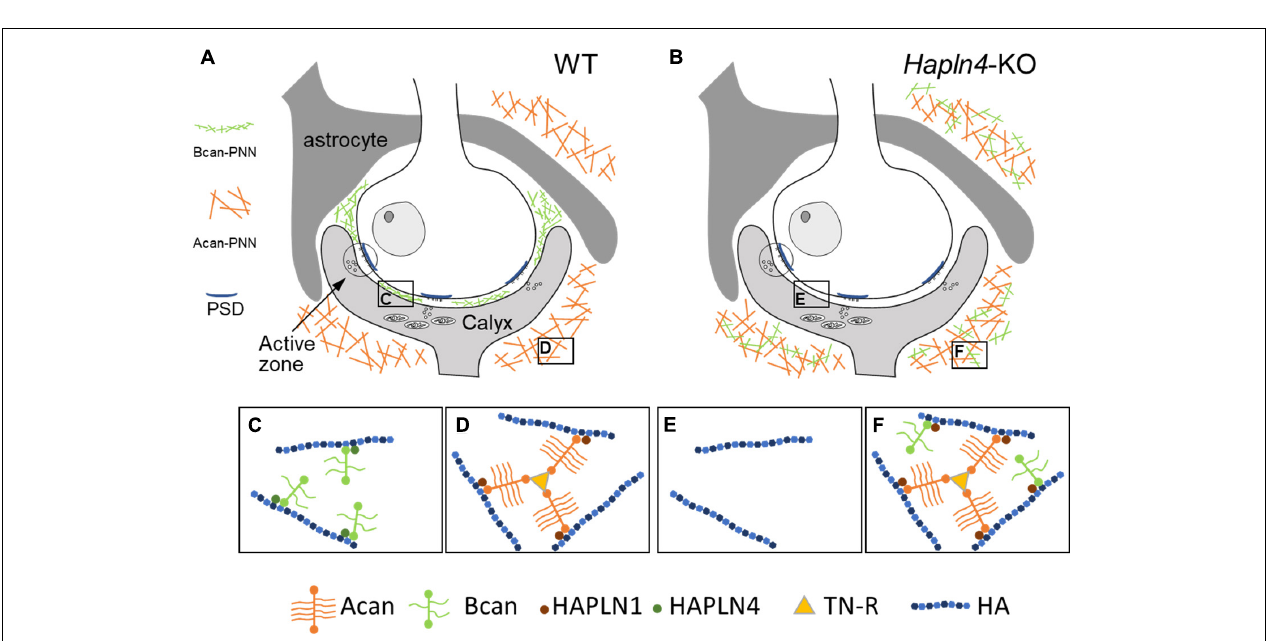
FIGURE 4 | Schematic representation of HAPLN-dependent perineuronal net (PNN) micro-organization at the calyx of Held synapses. (A,C,D) In wild-type mice, HAPLN4-brevican-type PNN is enriched in the perisynaptic space between the calyx of Held terminals and the principal neuron, and HAPLN1–aggrecan–tenascin-R-type PNN surrounds the whole calyx of Held terminals. (B,E,F) In Hapln4 -KO, the ectopic expression of brevican is detectable with HAPLN1 association at the surrounding extracellular space in the neuropil in addition to the HAPLN1–aggrecan–tenascin-R complex. Acan, aggrecan; Bcan, brevican; TN-R, tenascin-R; HA, hyaluronan; PSD, postsynaptic